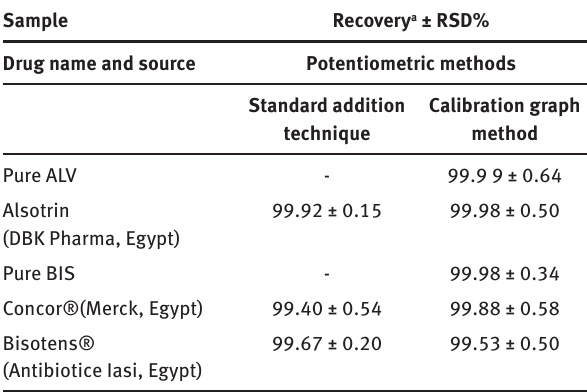
Table 6: Estimation of BIS and ALV in pharmaceutical preparations with standard addition and calibration graph methods